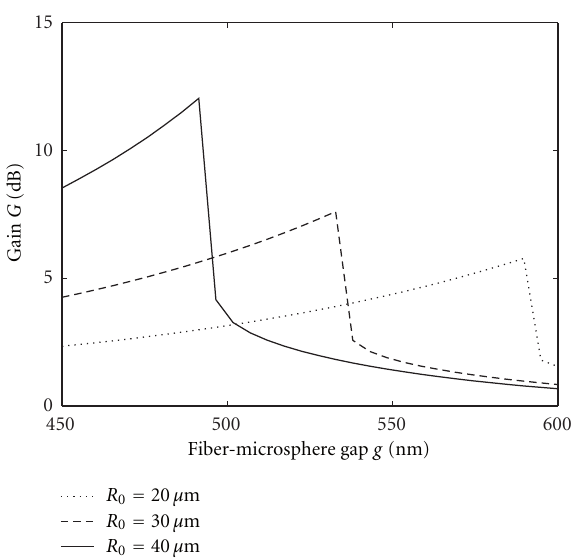
Figure 3: Signal amplification as a function of fiber-microsphere gap g for three di ff erent microsphere radii.